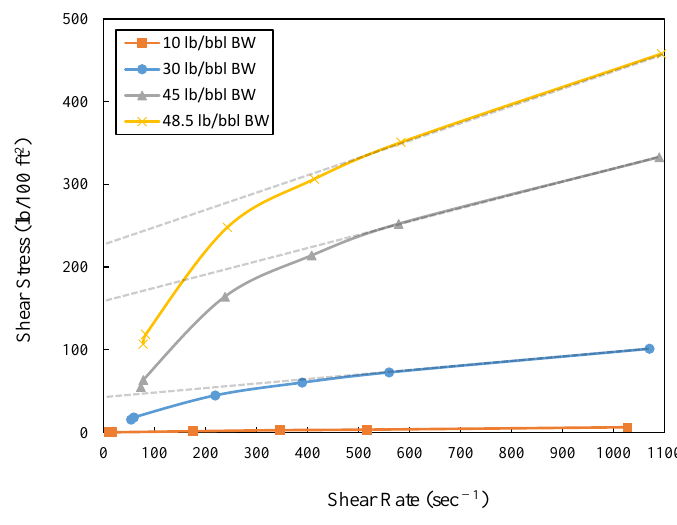
F igure A1. Shear stress against shear rate. Figure A1. Shear stress against shear